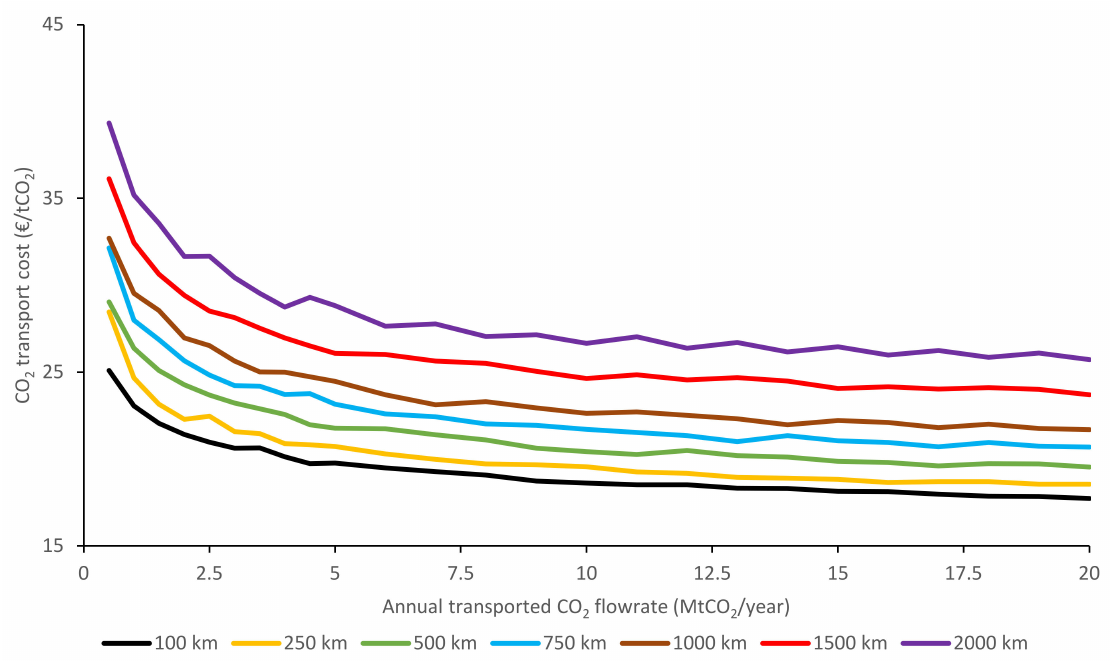
Figure A3. CO 2 conditioning and transport costs as a function of transport distance and annual volume when transporting pure CO 2 between two harbours by ship at 7